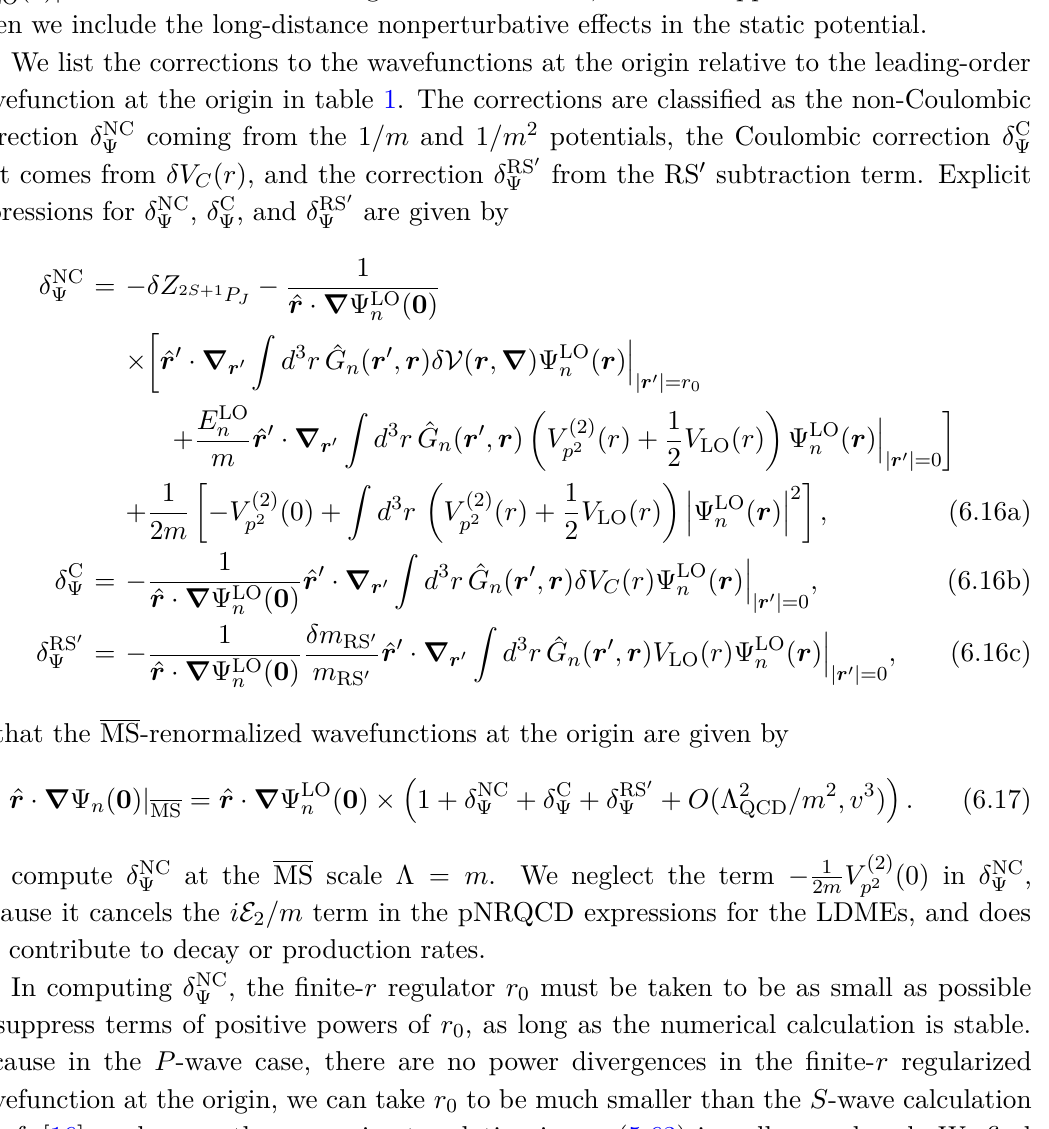
is the Coulombic correction, and δ RS 0 Ψ , δ C , and δ RS 0 Ψ Ψ